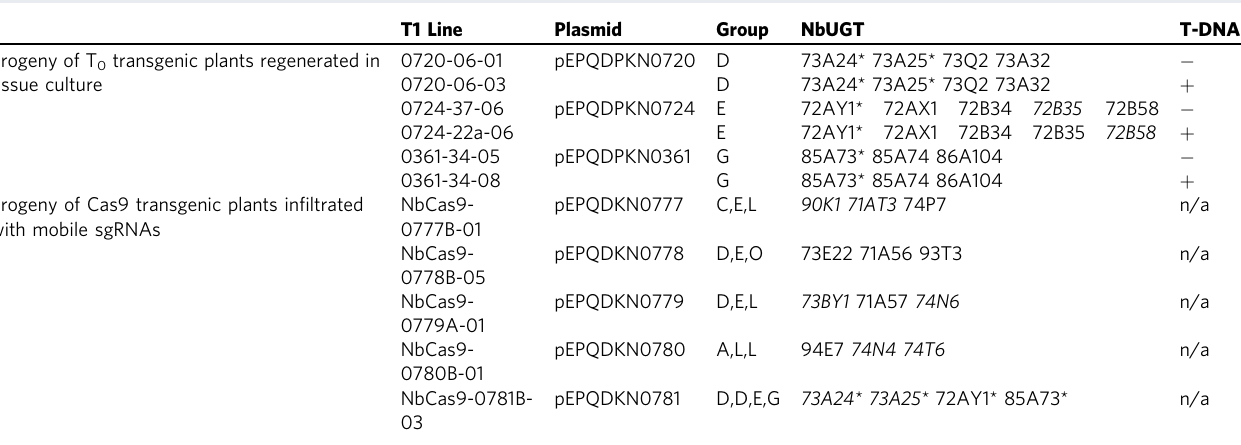
Table 1 Lines of N. benthamiana with Cas9-induced mutations in UGTs.